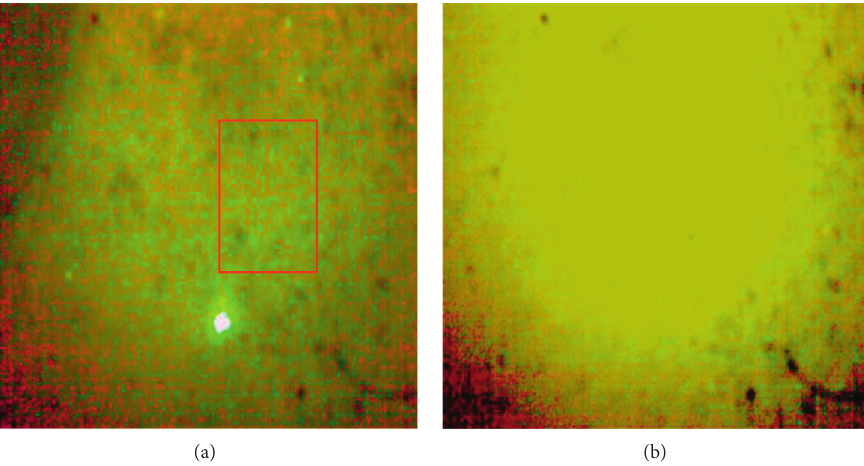
Figure 4: Fluorescence microscopy photo of ordinary rubber powder-modified asphalt and rubber powder with additives-modified asphalt: (a) ordinary rubber powder-modified asphalt; (b) rubber powder with additives-modified asphalt.